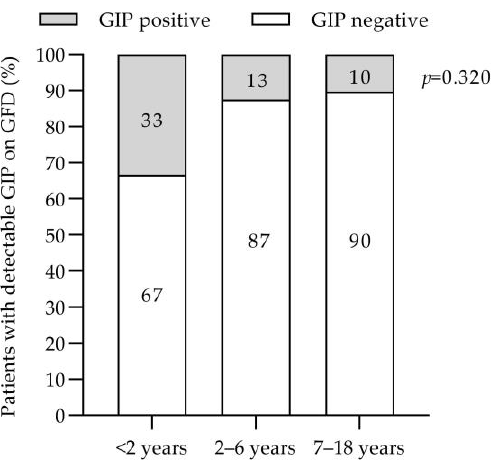
Figure 2. Stool gluten immunogenic peptide detection according to patient age. GIP, gluten immunogenic peptides. GFD, gluten-free diet.